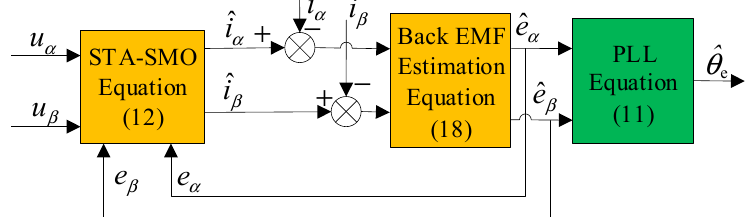
Figure 3. Sliding mode observer based on the super twisting structure diagram.